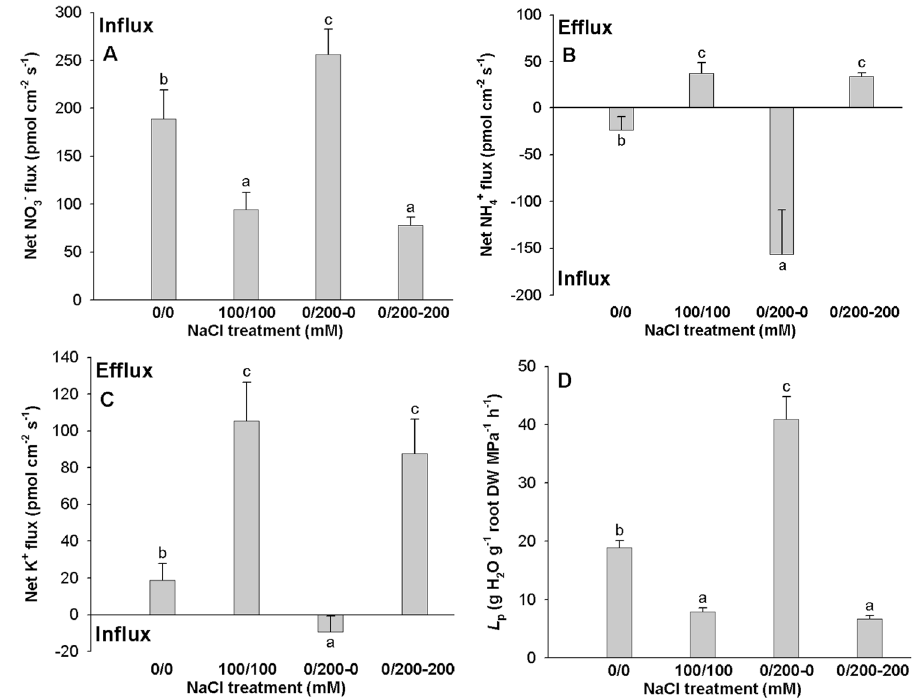
Figure 5. Effects of non-uniform (0/200 mM) and uniform (0/0 and 100/100) root zone salinity on net NO 3 − ( A ), NH 4 + ( B ) and K + ( C ) fluxes and Hydraulic conductance ( L p ) ( D ) in roots of cotton at 6 h after treatment. The data are main fluxes of NO 3 − , NH 4 + and K + within the measuring periods (15 min). Data are means of six biological replicates ( ± SD). Bars with different letters (a, b, and c) differ significantly at P <